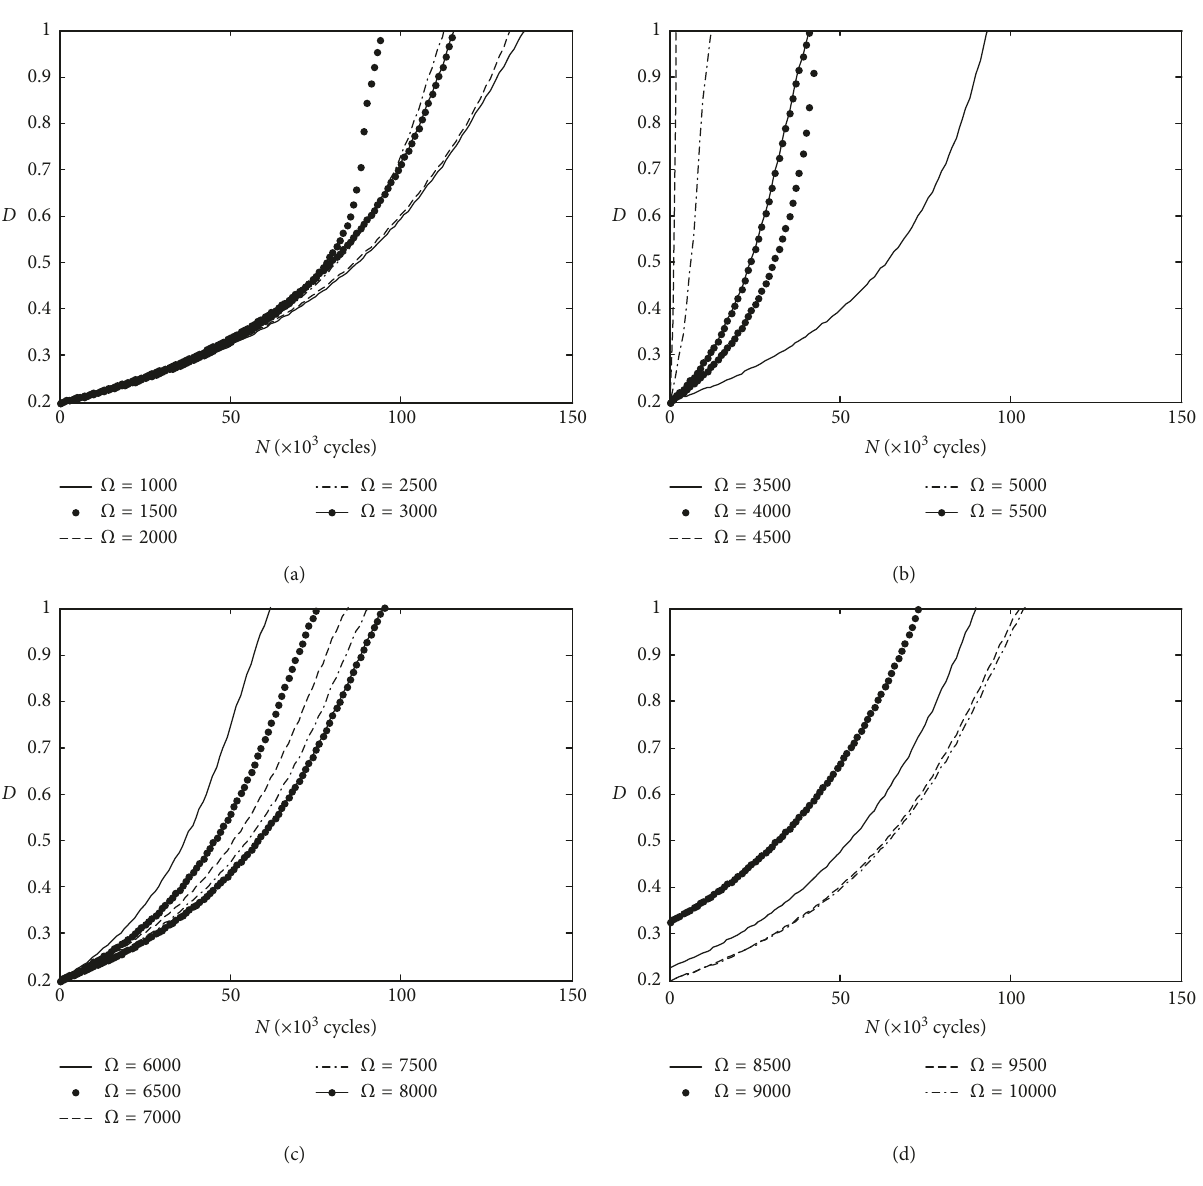
Figure 6: Degradation evolutions for various rotation